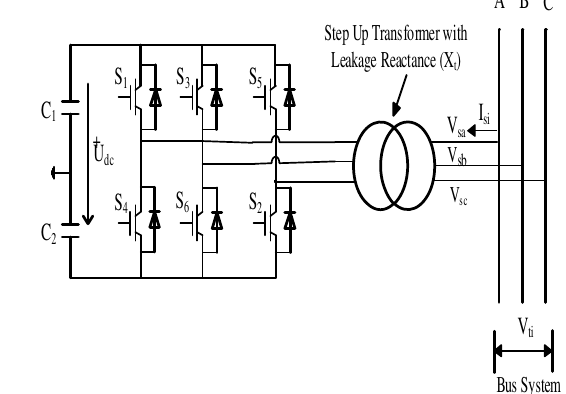
Fig.2: Detail Schematic Representation of 6-Pulse STATCOM Connected to AC bus